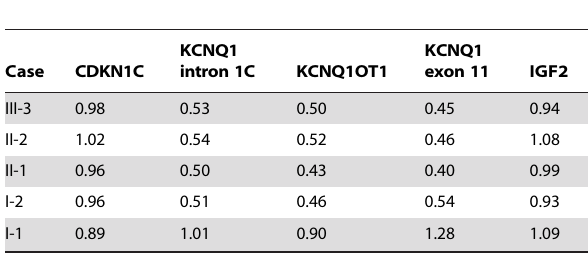
Table 1. Q-PCR determination of copy number.